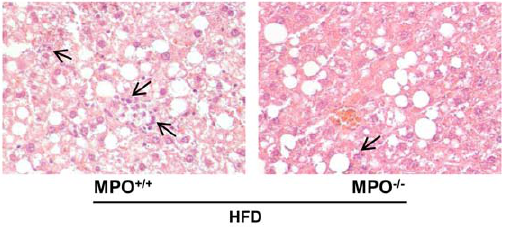
Figure 3. Liver histology of LDLR 2 / 2 / MPO 2 / 2 tp animals in comparison with LDLR 2 / 2 / MPO + / + tp mice after 8 weeks of high- fat feeding. Representative pictures of HE-stained liver sections of LDLR 2 / 2 / MPO 2 / 2 tp and LDLR 2 / 2 / MPO + / + tp mice indicating steatosis and inflammation (arrows).